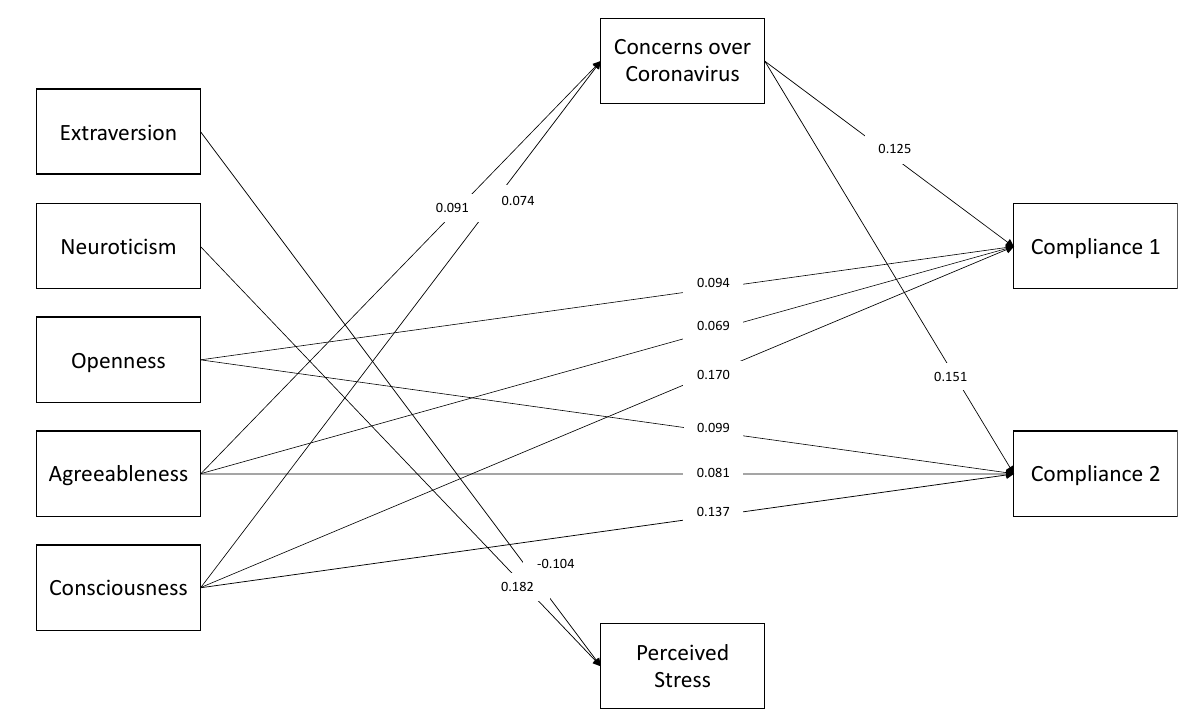
Figure 1. Prediction of measures abiding by the five personality traits through concerns over coro- navirus and perceived stress. Note. Estimates provided are standardized coefficients. Solid lines indicate significant paths. Residual terms, factor loadings, and the correlations between the inde- pendent variables were not provided for the sake of clarity.